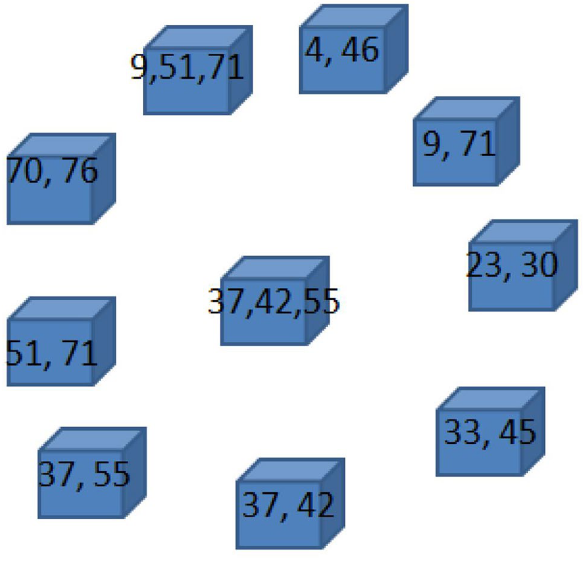
Figure 13. The 10 circuits, obtained from the NB simulation taken as model, are compared to other circuits which could emerge from different simulation parameters.